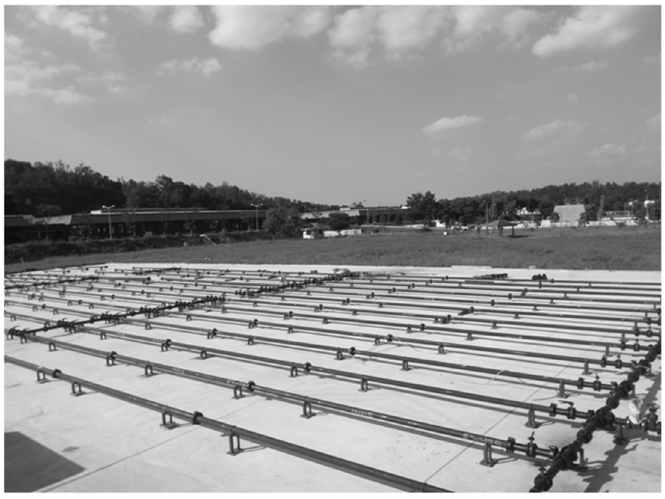
Figure 4. Front view of pilot plant.